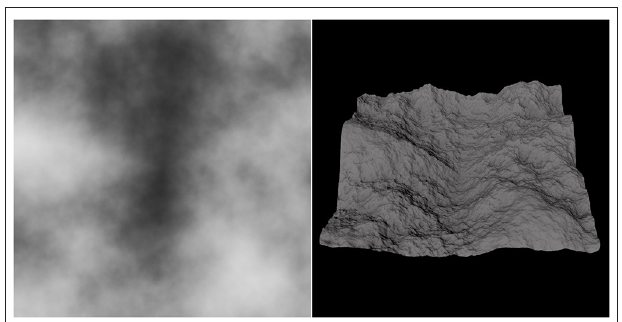
FIGURE 1 | Grayscale image sized 512 × 512 pixels, formed by progressively stacking seven layers of Perlin noise patterns at decreasing scales and intensity (Left) . Corresponding virtual terrain formed by using the grayscale image as heightmap, where greater luminance leads to higher terrain (Right)